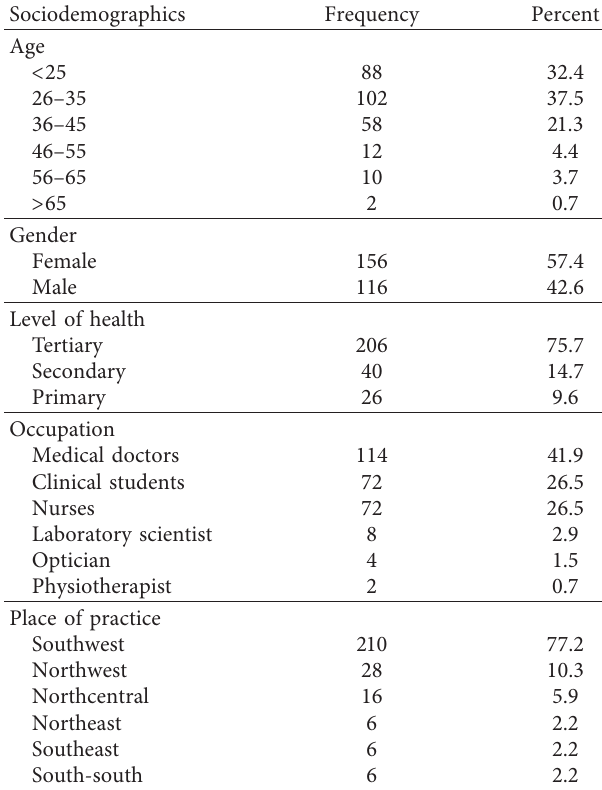
Table 2: Sociodemographic